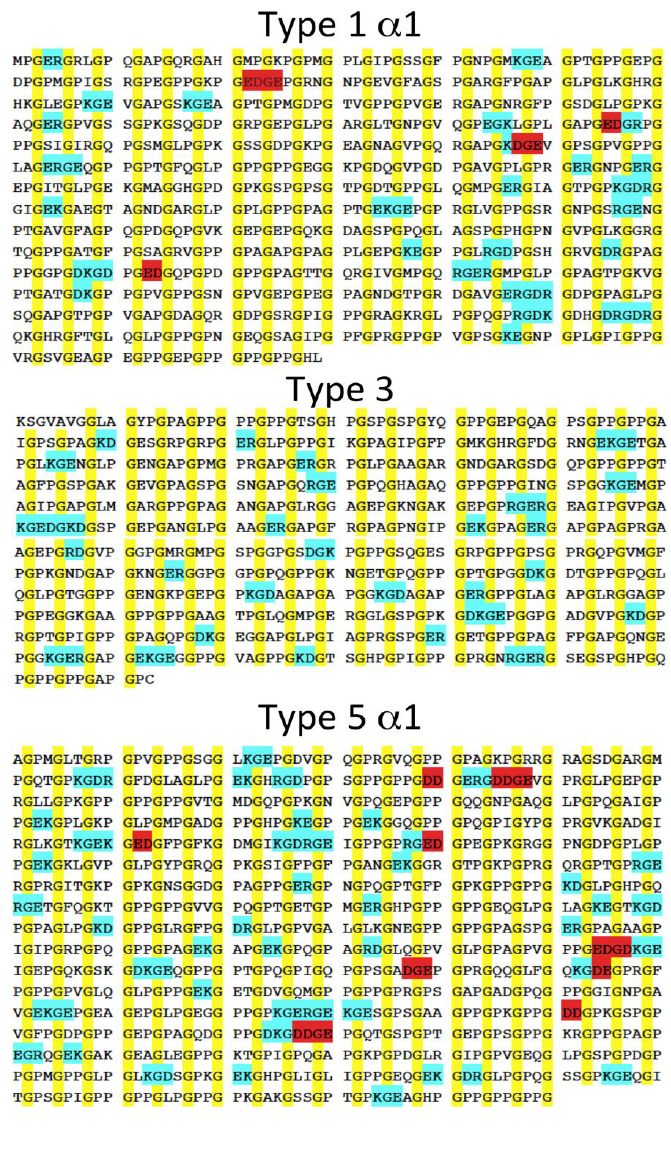
Figure 6. Sequence of fibrous natural collagens. Glycine is marked in yellow, clusters of like charges in red, clusters of favorable interactions in